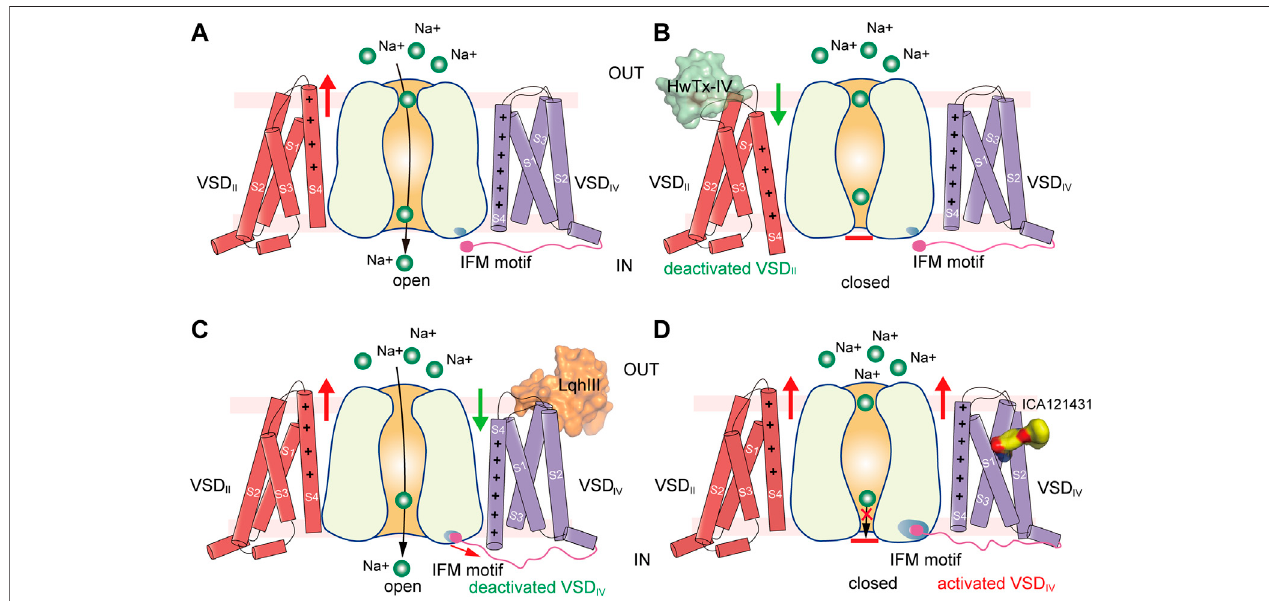
FIGURE 6 | Putative models for modulation of VSDs of Na V channels. (A) Activation of VSD I and VSD II cause channel opening. Green balls represent sodium ions. Redarrow indicatesactivationoftheVSD. (B) Site-4toxinHwTx-IVtrapsVSD II inadeactivatedstateand inhibitschannelopening.Greenarrowindicates deactivationof the VSD. (C) α -Scorpion toxin LqhIII traps VSD IV in a deactivated state and inhibits fast inactivation. (D) Aryl sulfonamide analogue ICA121431 binds to activated VSD IV and inhibits channel